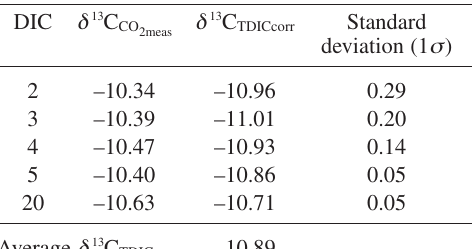
Table II. Mean δ 13 C CO measurements for the aque- 2 ous standard solutions at five different DIC contents (2, 3, 4, 5 and 20 mmol/l). Each value represents the average of ten analyses. δ 13 C TDIC values have been computed according to the correction factors report- ed in table I. All the isotope values are expressed in δ ‰ versus PDB international